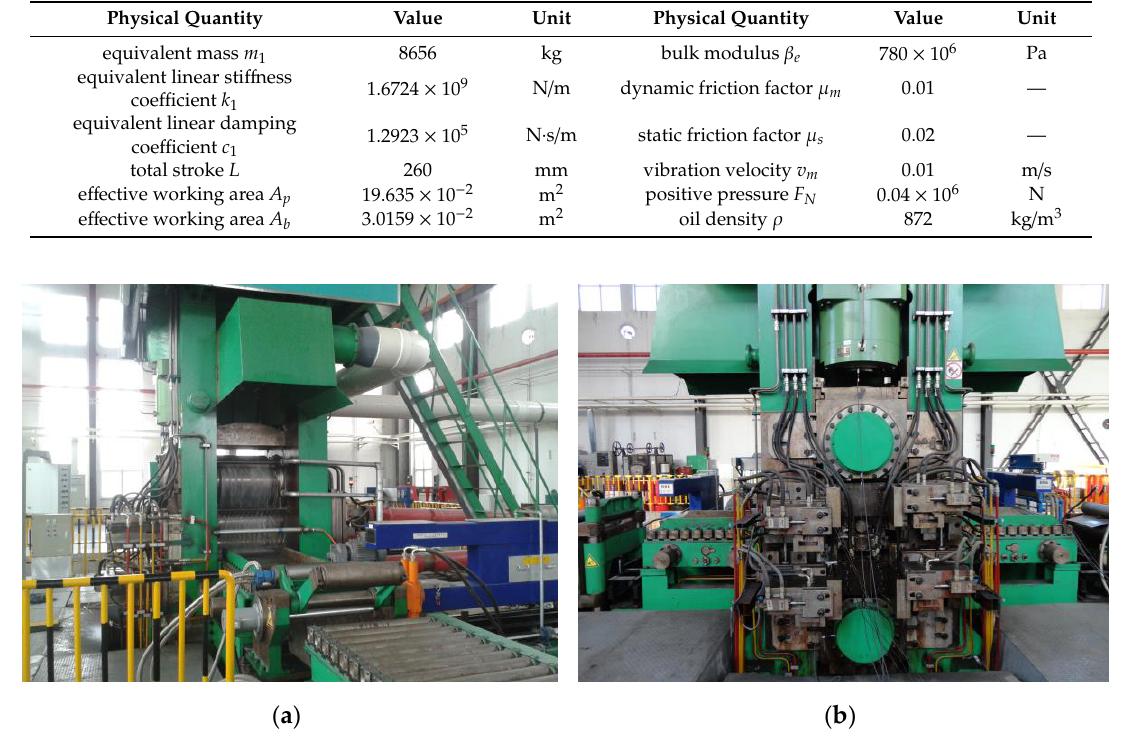
Table 1. Parameters of the numerical experiment.